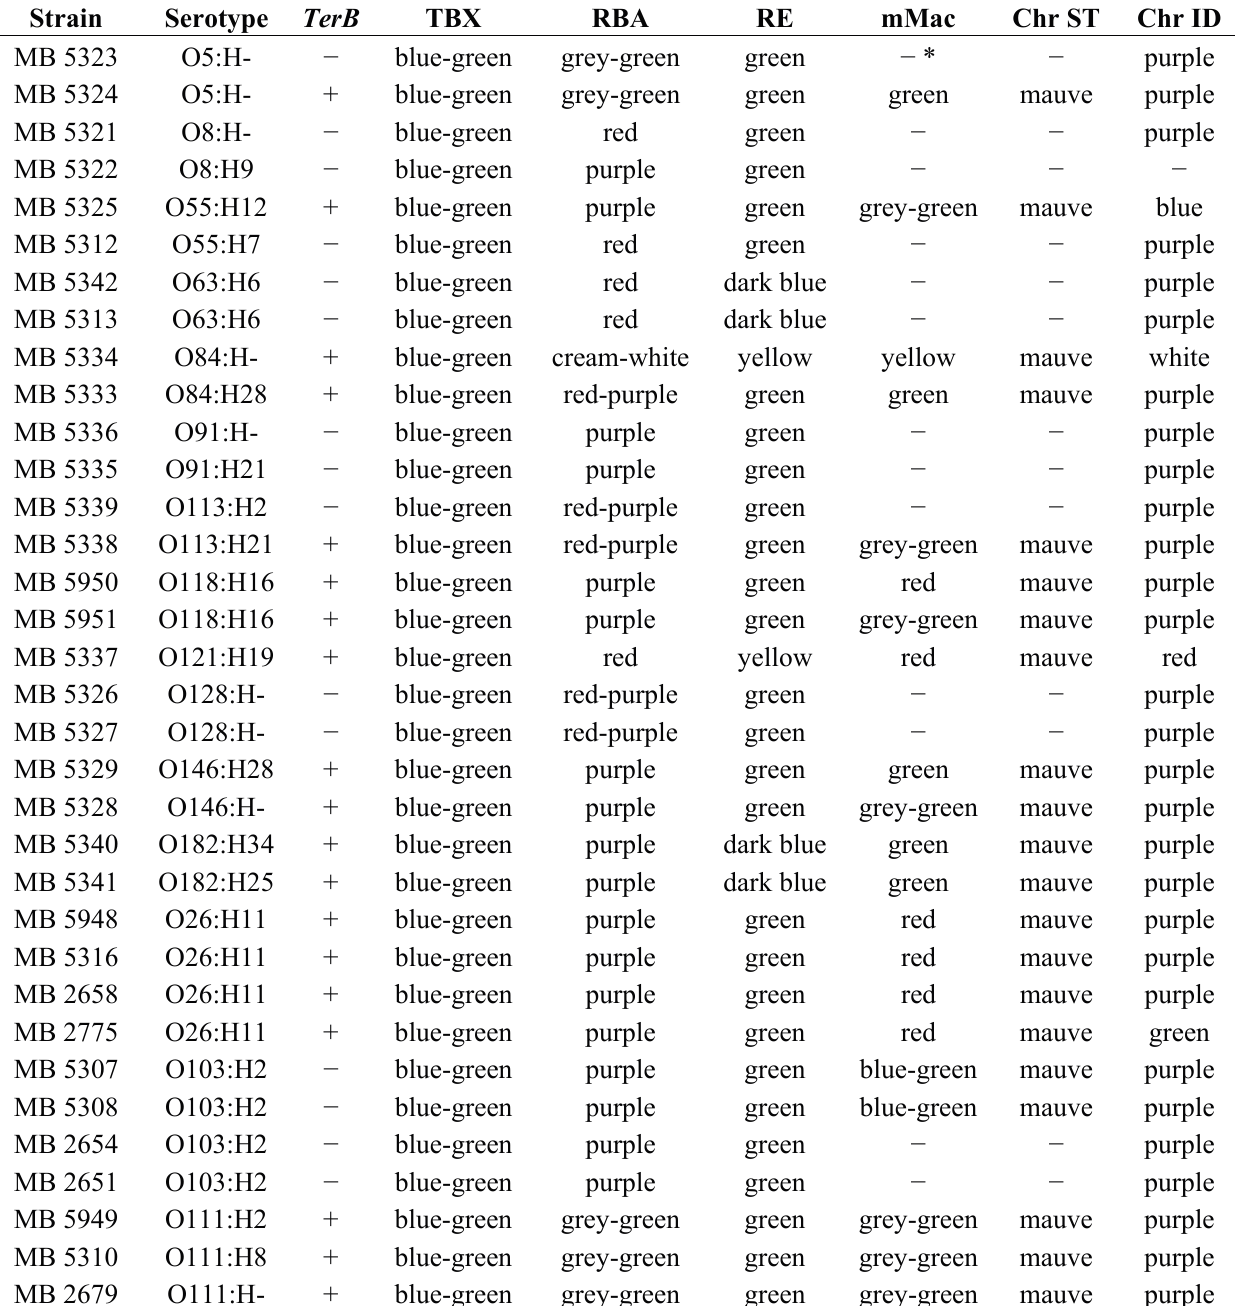
Table 2. Growth and colony appearance of STEC and non-STEC E. coli strains on six chromogenic isolation